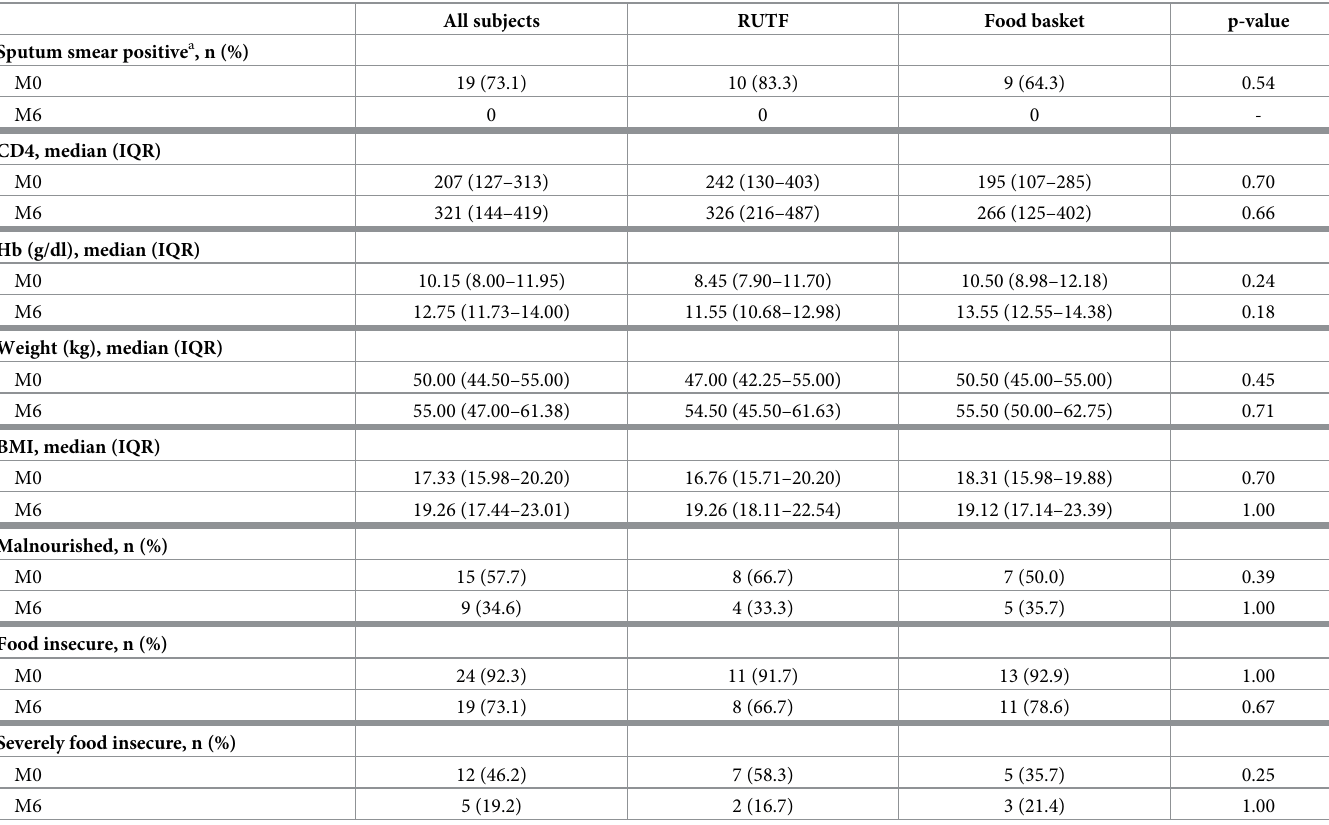
Table 3. Clinical outcomes, nutritional status, and food insecurity among participants who received RUTF versus the food basket. All subjects RUTF